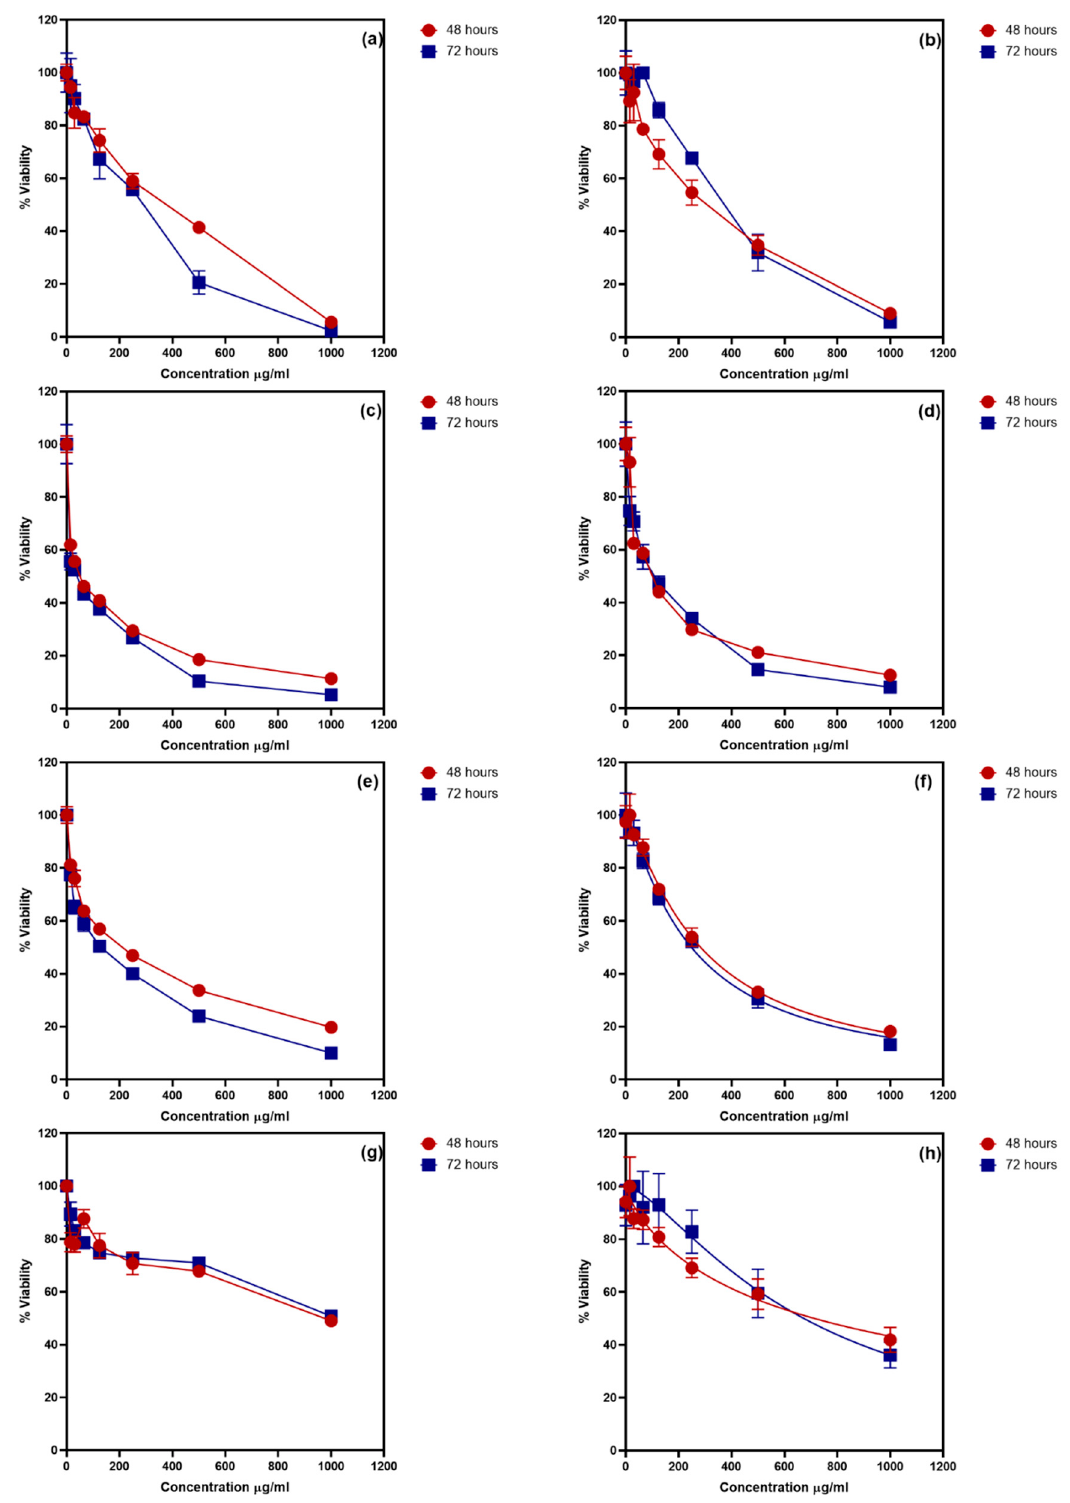
Figure 3. Graphical representation of cell viability percentage with M. peregrina stem extracts on MCF-7 and Caco-2 cells with 48 and 72 h incubation: ( a )—Hexane extract in MCF-7; ( b )—hexane extract in Caco-2; ( c )—chloroform extract in MCF-7; ( d )—chloroform extract in Caco-2; ( e )—acetone extract in MCF-7; ( f )—acetone extract in Caco-2; ( g )—methanol extract in MCF-7 and ( h )—methanol extract in Caco-2. Values are expressed as mean ± SD of three experiments ( p -value relative to control group: p < 0.05).